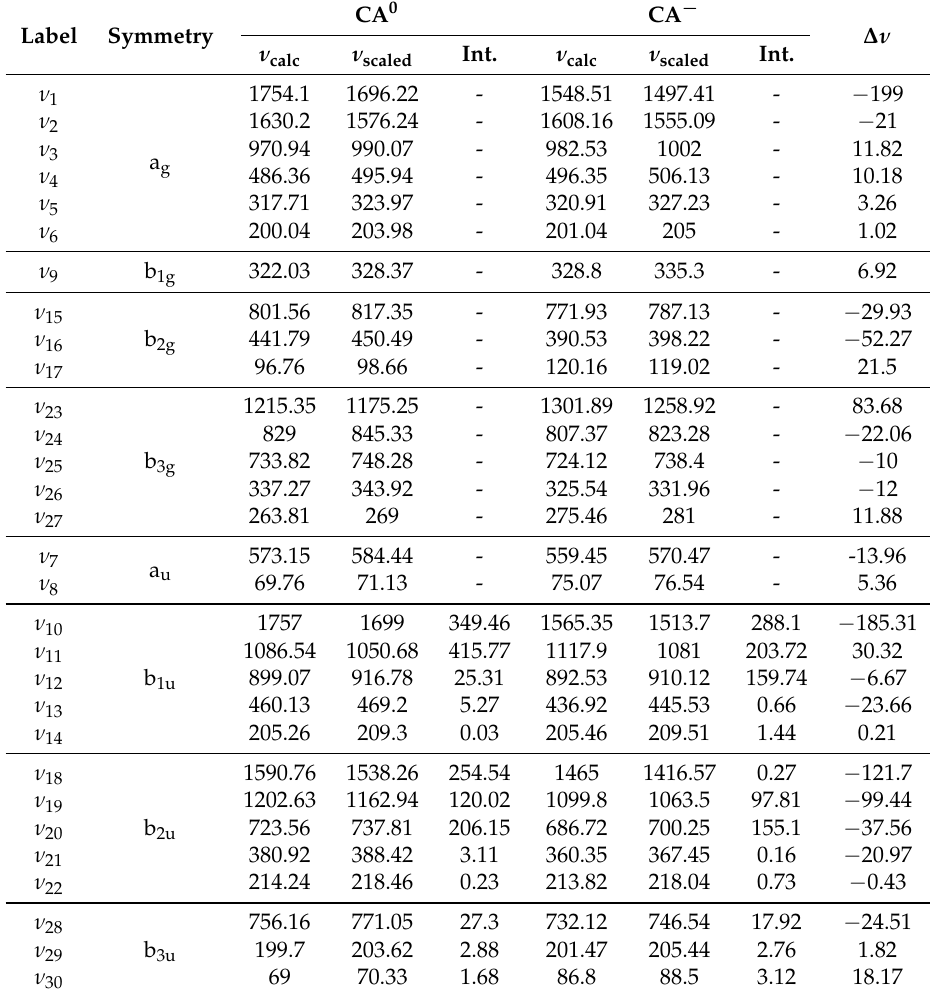
Table C1. Calculated frequencies in cm − 1 and infrared intensities (Int.) given in units of D 2 amu − 1 · Å − 2 of neutral CA and ionized CA −